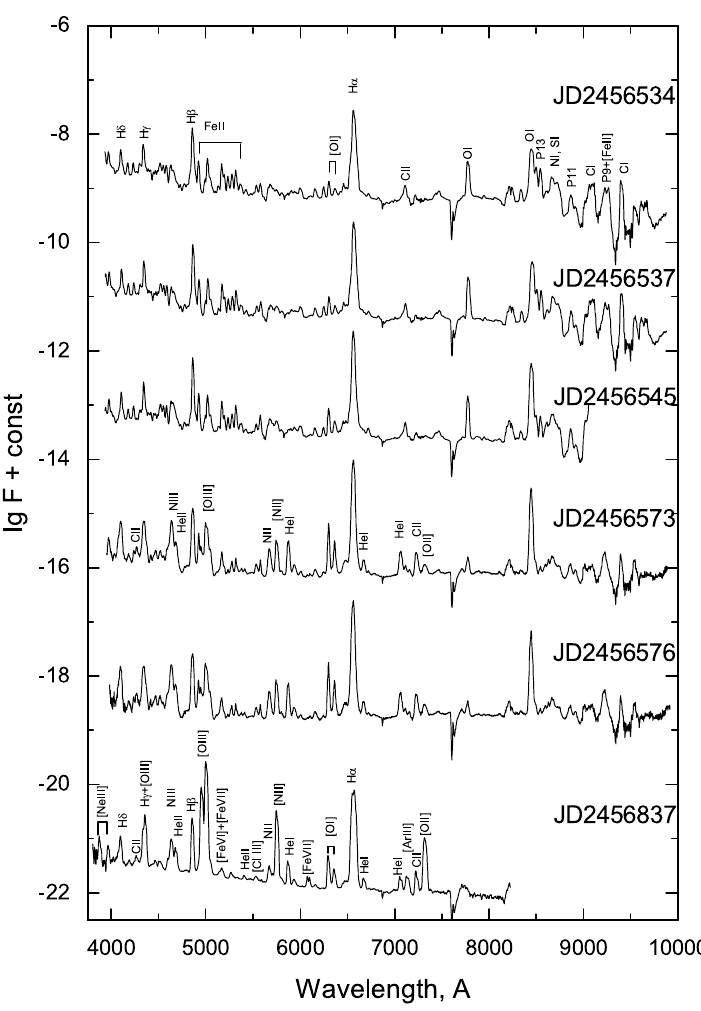
Fig. 3. Spectral evolution of Nova Del